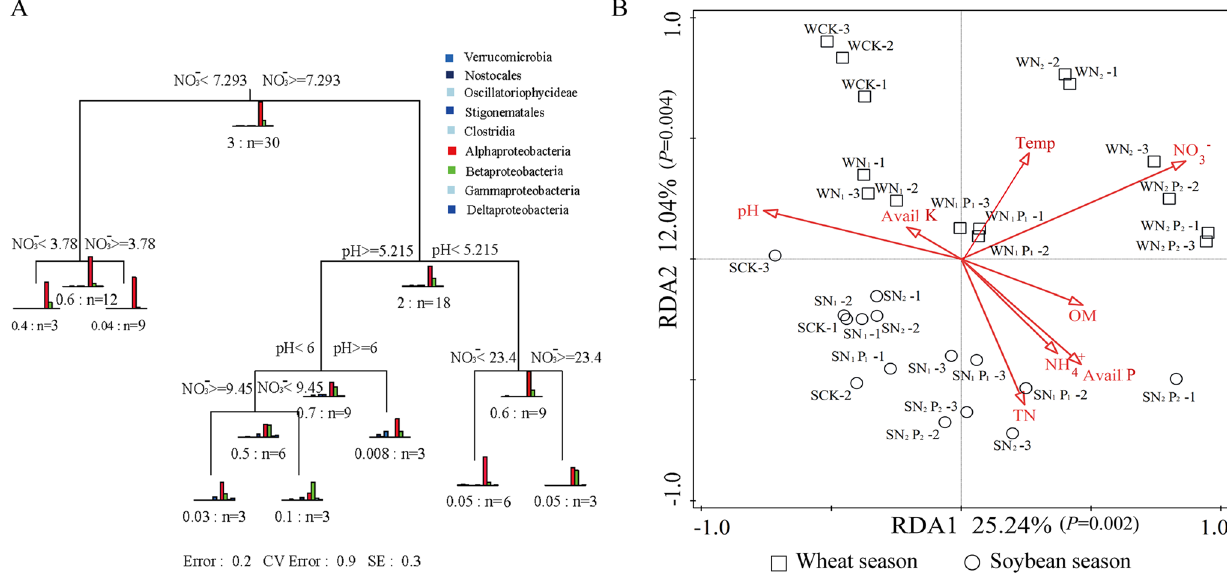
Figure 5. The relationship between the N-fixing community composition and soil chemical properties. ( A ) Multivariate regression tree (MRT) analysis was performed to interpret the relationship between the nitrogen- fixing community composition and soil chemical properties at the class level. ( B ) Redundancy analysis (RDA) was performed to assess the relationship between the nitrogen-fixing community composition and soil chemical properties at the genus level. W soil samples in the wheat season, S soil samples in the soybean